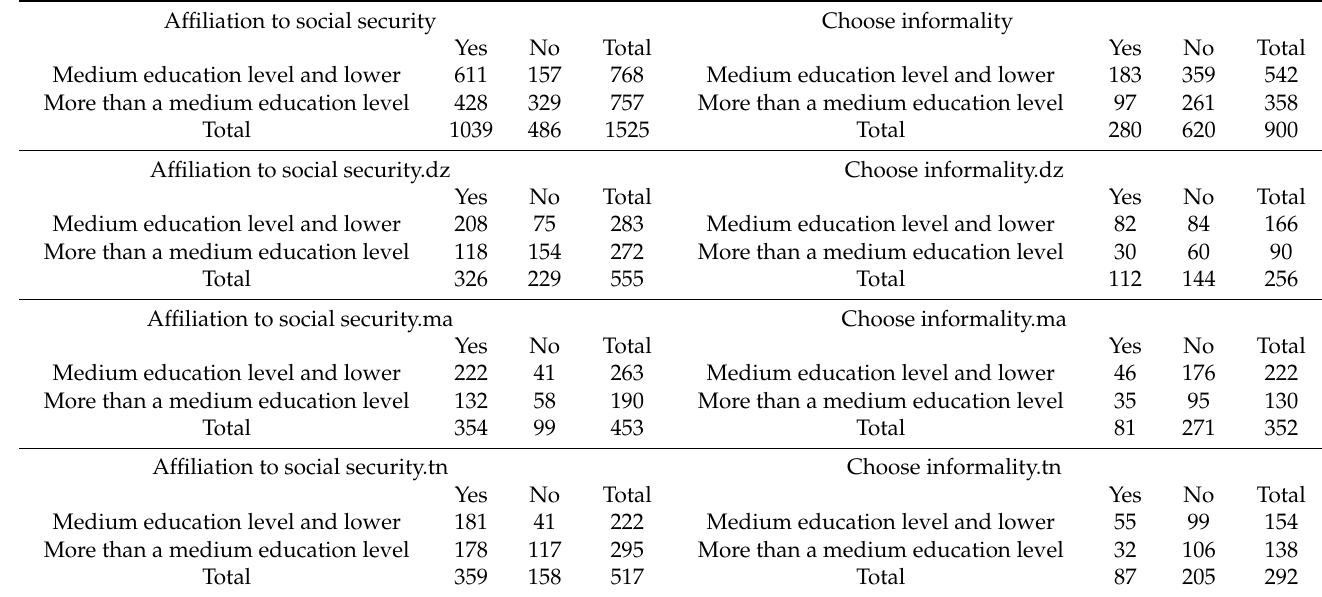
Table A3. Affiliation to social security and the reason for not being insured according to level of education. Source: Sahwa dataset.